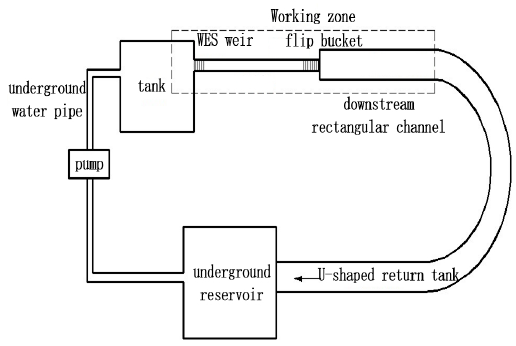
Figure 2. General layout of the experiment setup.